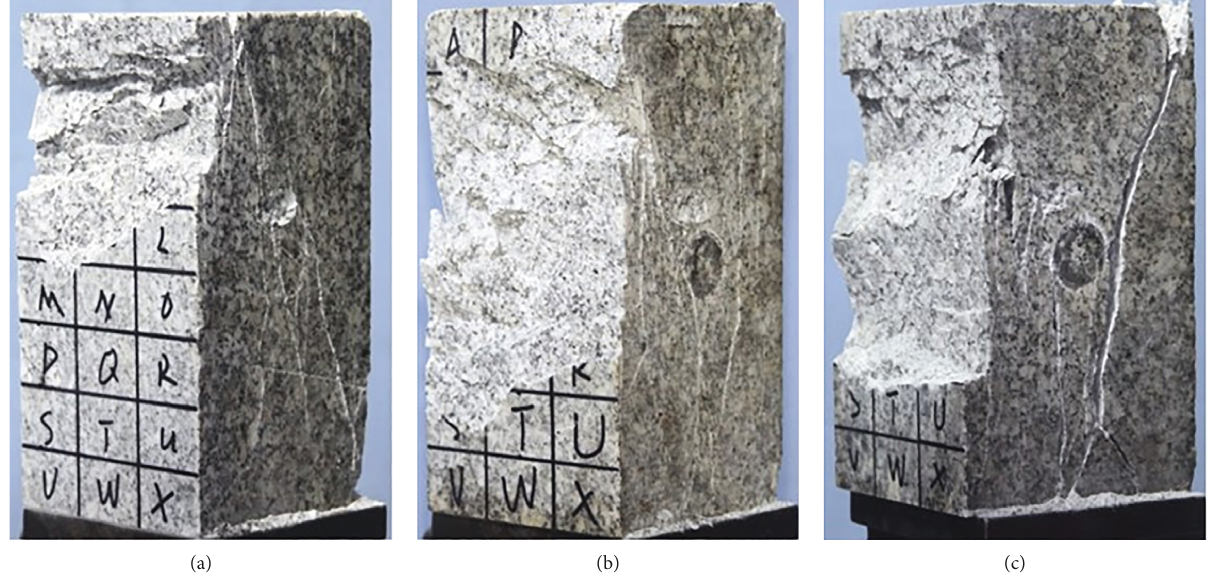
3 (cid:31) 0.1MPa; (b) σ 3 (cid:31) 1 MPa; (c) σ 3 (cid:31) 3MPa.